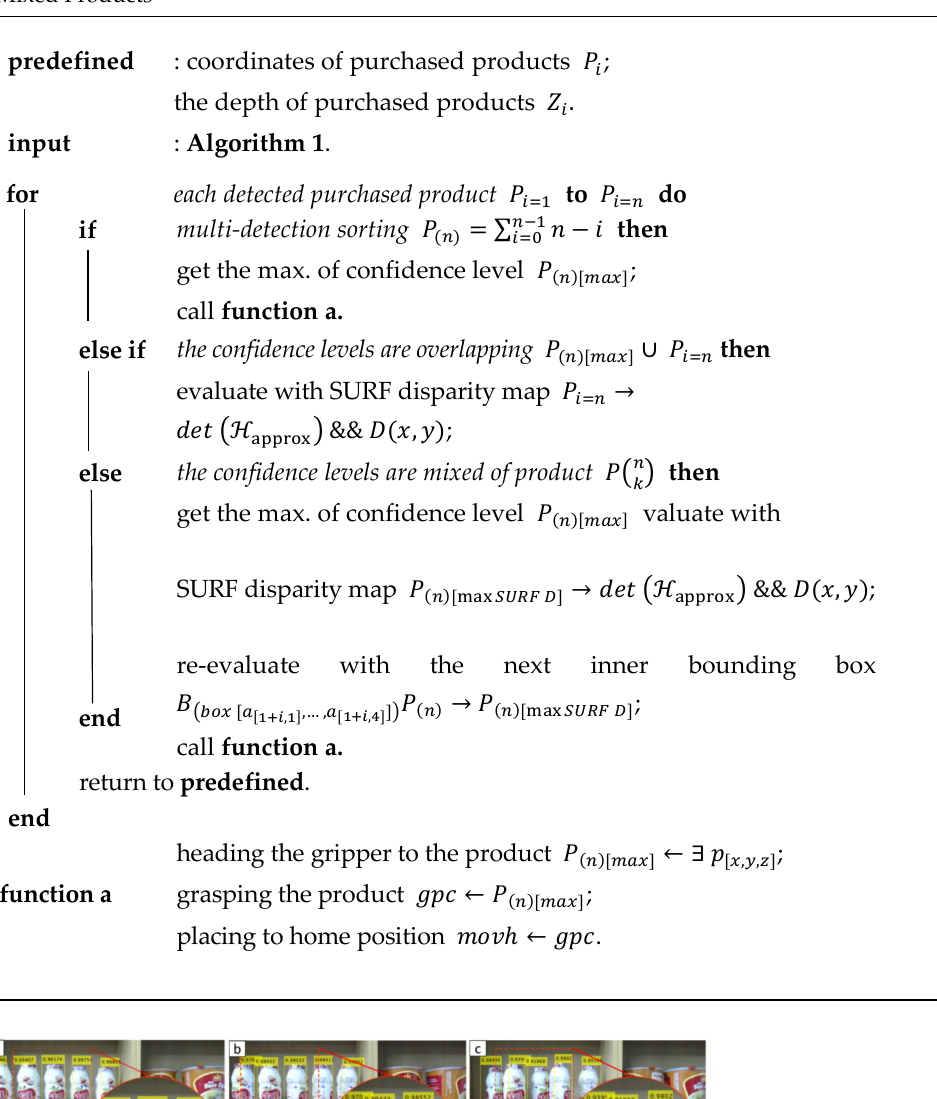
Algorithm 2 Ascertain Whether Purchased Product Is Within Multi-Detection, Overlapping, or Mixed Products